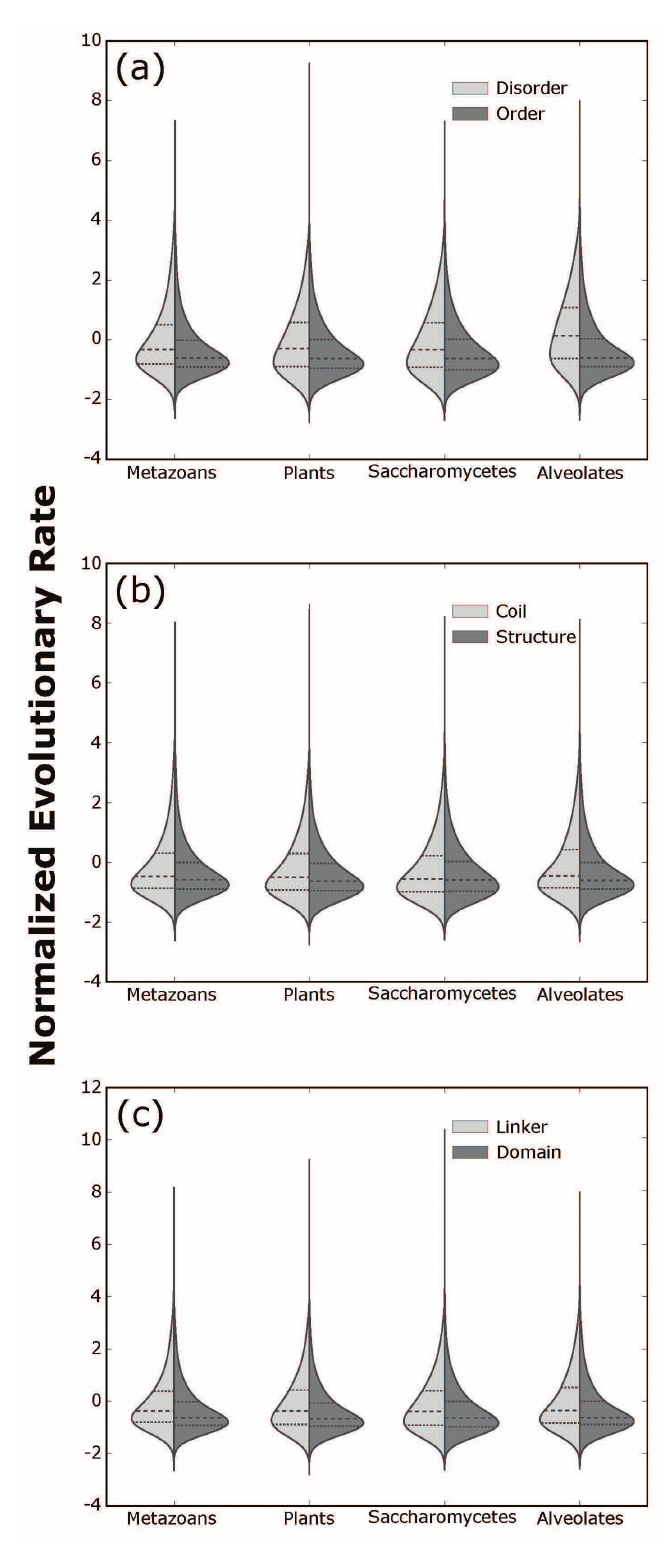
Figure 2. Split violin plots showing differences in normalized site-specific rates of amino acid replacement in: ( a ) ordered vs. disordered sites; ( b ) structured vs. coil sites; and ( c ) domain vs. linker sites within four eukaryotic datasets. Middle dashed lines indicate medians and outer dashed lines indicate